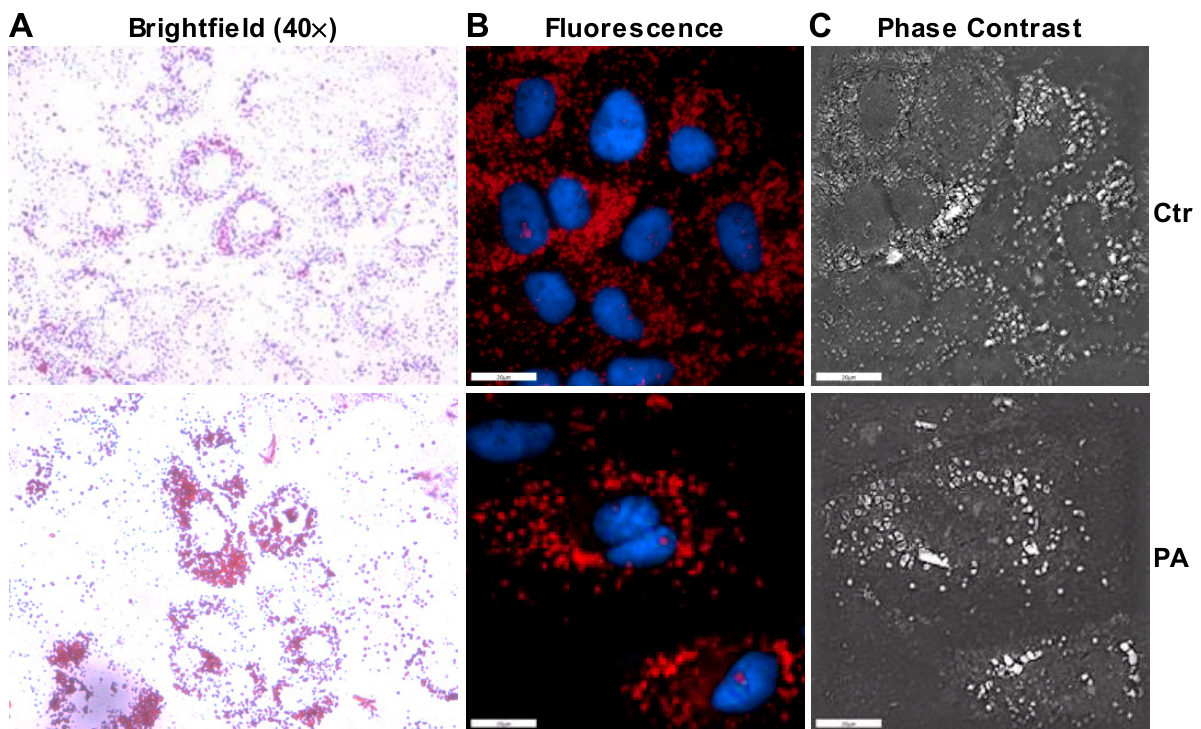
Figure 3. Palmitate induces morphological changes in Huh-7 cells. Huh-7 cells were treated without (Ctr) or with 0.2 mM of palmitate (PA) for 16 h prior to staining them with Oil Red O. Cells were used to determine the morphological changes and accumulation of lipid droplets using the bright- field (Panel A ), fluorescence (Panel B ), and phase contrast (Panel C ) microscopy. Representative photographs of each condition is shown above in the figure.